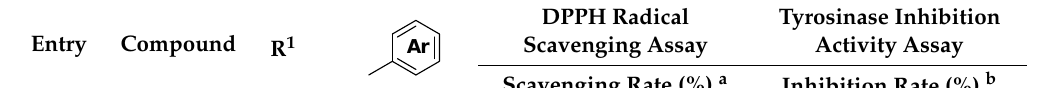
Entry Compound R 1